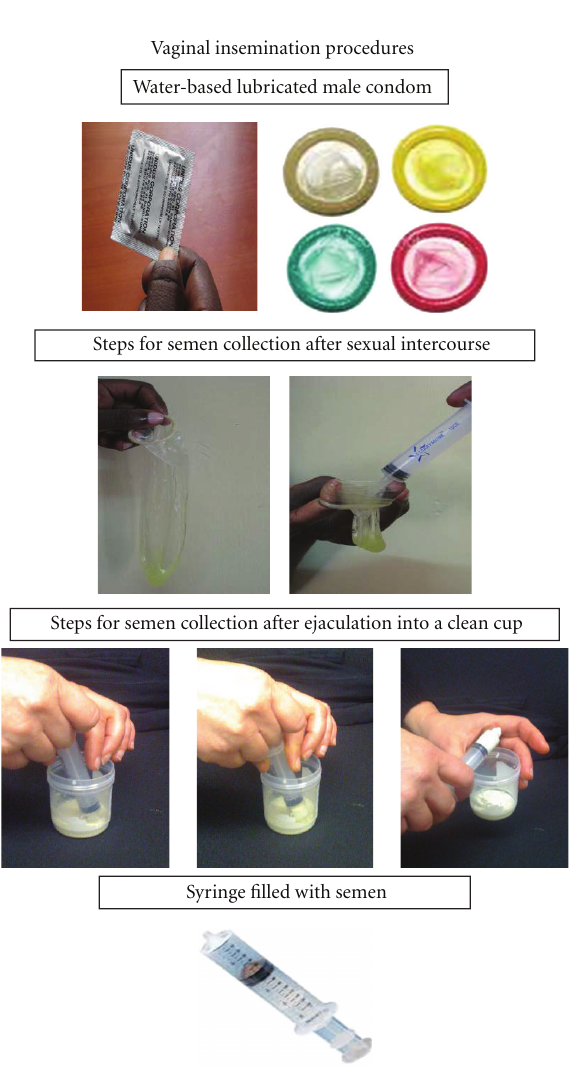
Figure 1: Steps for vaginal insemination of semen: (1) on a fertile day of the menstrual cycle, engage in sex using nonspermicidal condom (water-based lubricated or nonlubricated condom) or semen can be collected from a clean cup after ejaculation. (2) Collect the semen with a plastic needle-less syringe from a condom or clean cup. (3) The female or male partner will insert the syringe with the semen as high as possible into the vagina, ideally immediately after ejaculation. (4) The female partner may lie down for at least thirty minutes after insertion. (5) Steps (1–4) may be repeated every other day during the fertile